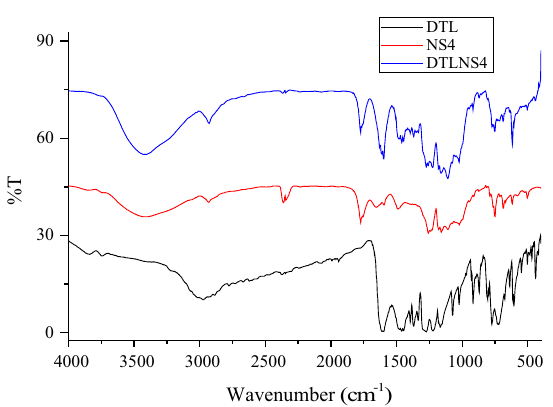
Fig. 5 FTIR spectrum of DTL (dithranol), NS4 (nanosponges formulation) and DTLNS4 (dithranol nanosponges)